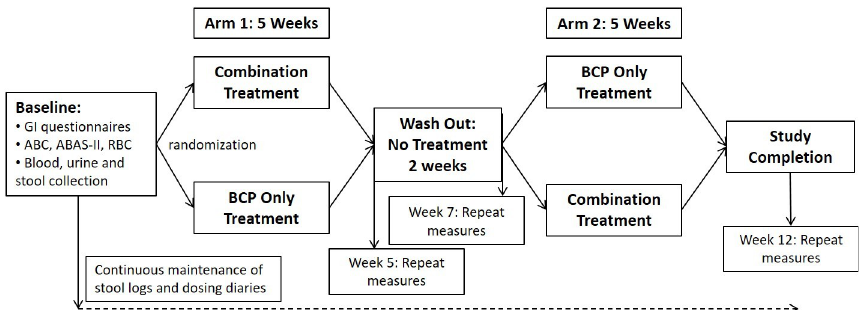
Fig 2. Study design flow chart. Diagram describing the study design including outcomes measured, timing and duration of the study period.